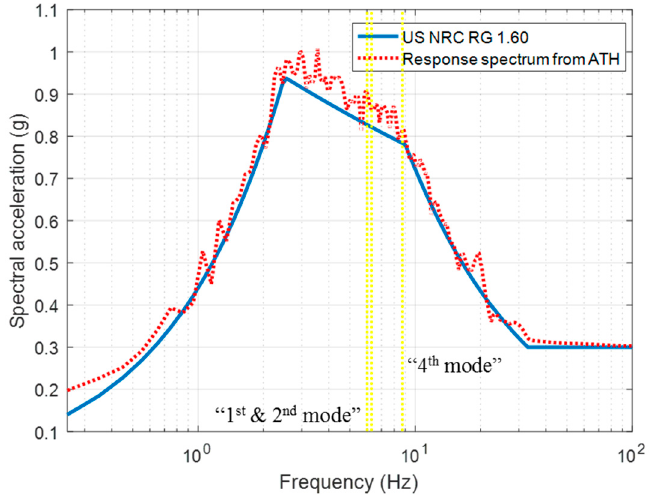
Figure 2. Seismic design response spectrum and expression of the TMD installation target modes